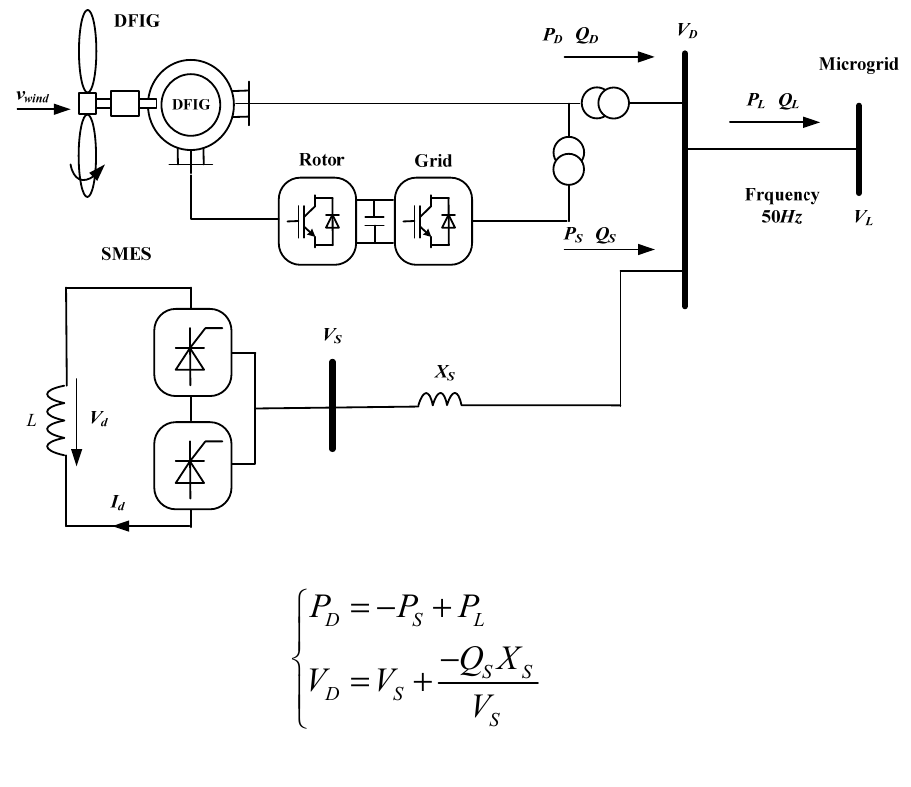
Figure 1. DFIG-SMES